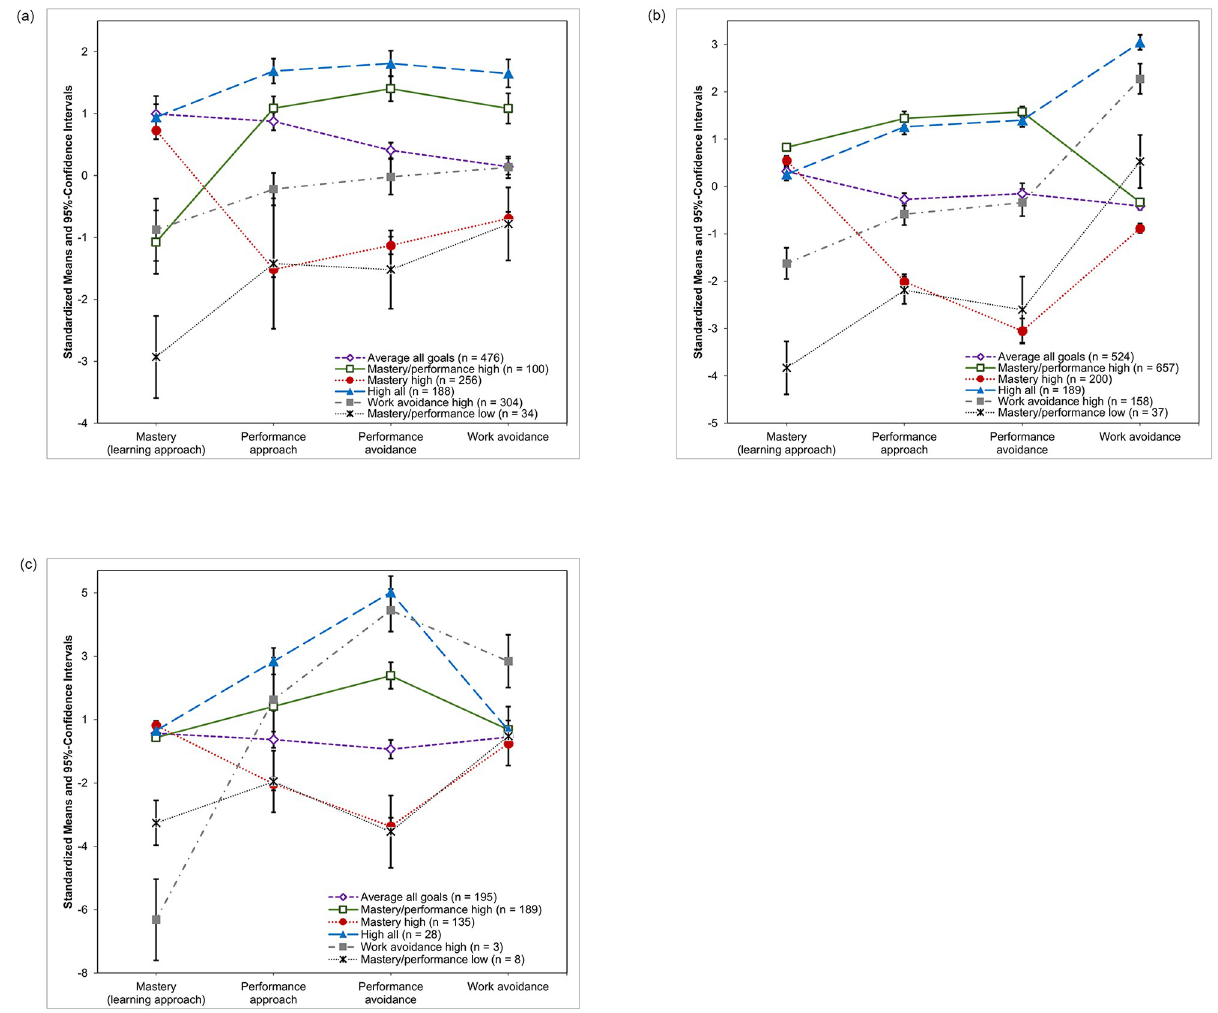
Fig 1. Goal means for the six latent profiles (with 95% confidence intervals). (a) Israel school teachers. (b) German university teachers. (c) German school